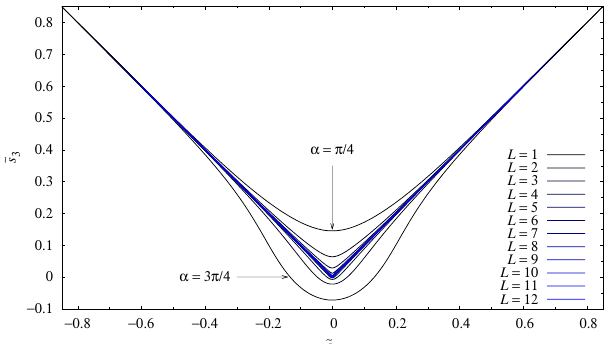
Figure 7. A parametric plot of the \symmetric" CP N (cid:0) 1 variables for (cid:11) = (cid:25) diagonal straight lines emanating from the origin) and (cid:11) = 3 (cid:25)